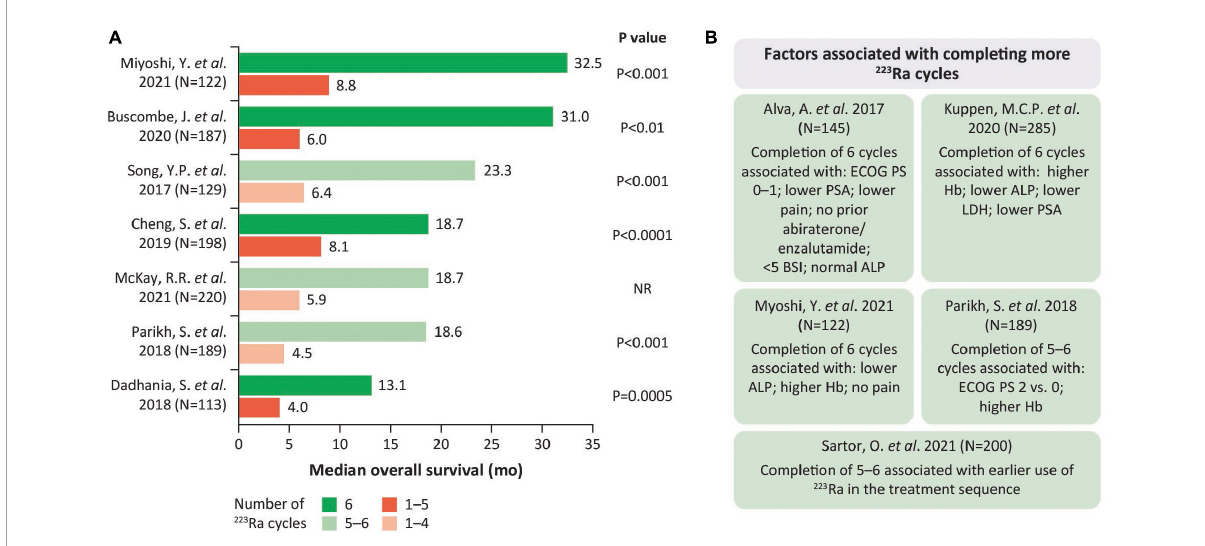
FIGURE1 Completing more 223 Ra cycles is associated with longer OS. (A) Median OS by 223 Ra cycle number. (B) Factors associated with completing more 223 Ra cycles. ALP, alkaline phosphatase; BSI, bone scan index; ECOG PS, Eastern Cooperative Oncology Group performance status; Hb, hemoglobin; LDH, lactate dehydrogenase; OS, overall survival; PSA, prostate-specific